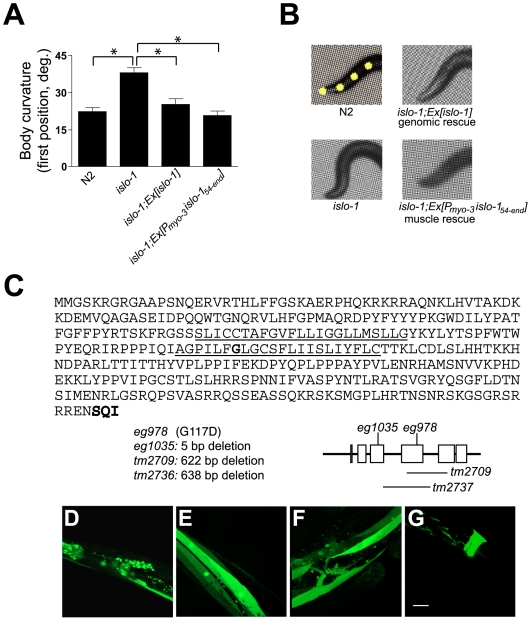
Transgenic rescue and cloning of islo-1.(A) The first curvature angle obtained from wild-type (N2) and islo-1(eg978), and islo-1 transgenic rescue strains (genomic rescue strain, islo-1;Ex[islo-1], and muscle specific rescue strain, islo-1;Ex[P myo-3 islo-154-end]). Error bars, SEM. Asterisks represent significant difference between islo-1 and other animal groups (P<0.05). (B) Representative photos show the anterior portion of animals. (C) The predicted amino acid sequence of ISLO-1. The predicted transmembrane domain sequences are underlined and the type I PDZ recognition sequence is bold. (D–G) The expression pattern of the islo-1 gene. The upstream sequence of the predicted translation initiation site was inserted into a GFP coding sequence in frame, and the resulting DNA was used for generating transgenic animals in wild-type animals. Expression was observed in neurons (D), body-wall muscles (E), egg-laying muscles (F) and enteric muscles (G). Scale bar, 10 µm.